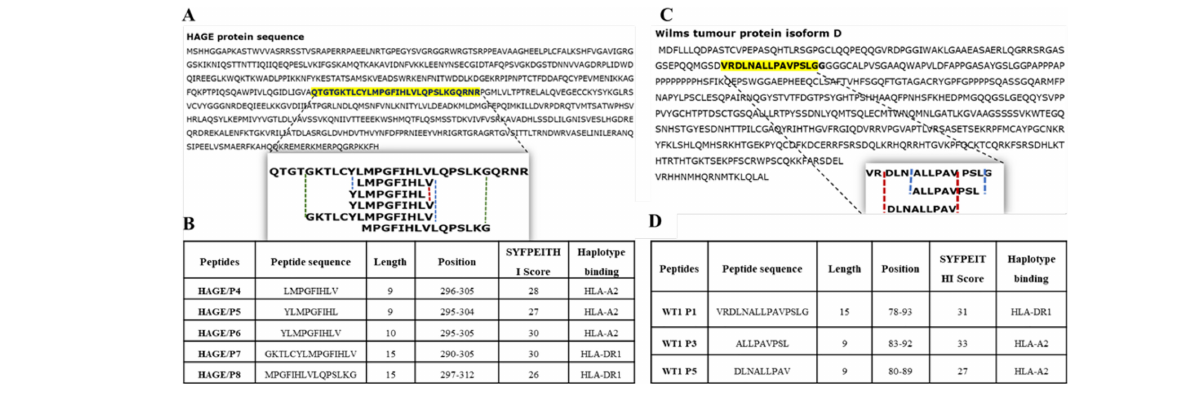
The entire HAGE protein sequence of 648 amino acid length, from which the long 30-mer (yellow highlighted in A) and other short 9-15-mer peptides derived from the long 30-mer are shown in A&B. This length was fully copied from NCBI website/FASTA, available at: https://www.ncbi.nlm.nih.gov/protein/Q9NXZ2.2?report=fasta. Whereas the entire WT1 protein sequenceof522aminoacidlength(Isoform-D),fromwhichthelong15-mer(yellowhighlightedinC)andthetwoothersshortpeptidederivativesareillustratedinC&D.Thislengthwasfully copied from NCBI website/FASTA available at: